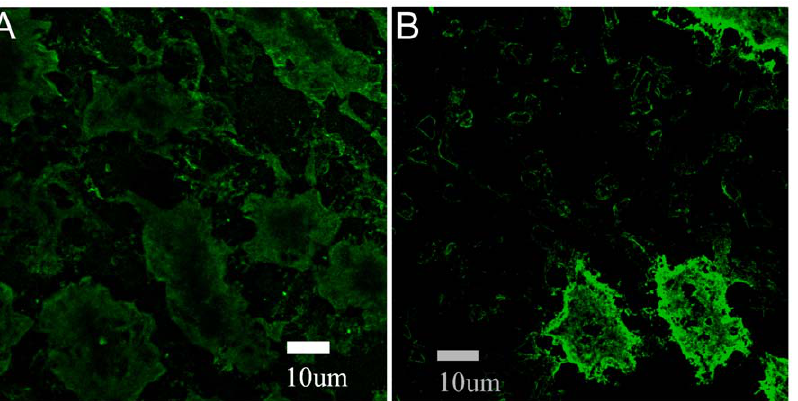
Figure 7. Sample CLSM images of native NBCe1-A on basolateral cell membranes of rat kidney. Post fixation, tissues were immunolabeled with the primary anti-wt-NBCe1-A antibody (I) and the secondary (II) Alexa Fluor 488 conjugated antibody. Panel A shows non- specific secondary antibody staining in the absence of the primary. Panel B shows kidney cells immunostained with both antibodies. The pixel size is 0.0921 m m. The images were taken at identical acquisition conditions so valid comparisons between different images could be made. The image contrast was enhanced for visualization and comparison purposes.